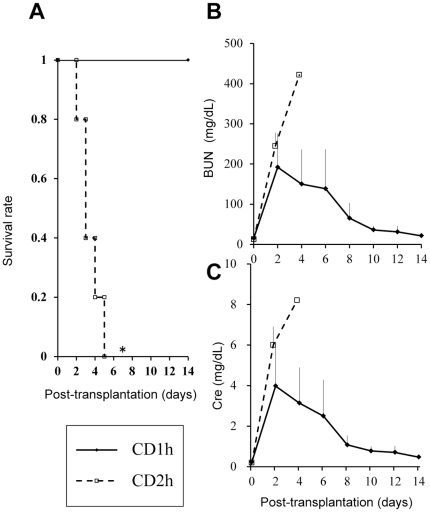
Survival rate, blood urea nitrogen (BUN) and serum creatinine (Cre) levels in experiment 1.(A): Survival rate of each group. Survival rate of the CD1h group was significantly greater than that of the 2-h post-CD group (* p<0.01 using Log-Rank test.). (B): BUN. (C): Cre. BUN and Cre levels of all surviving rats were gradually recovered to a normal range by day 14 after RTx.